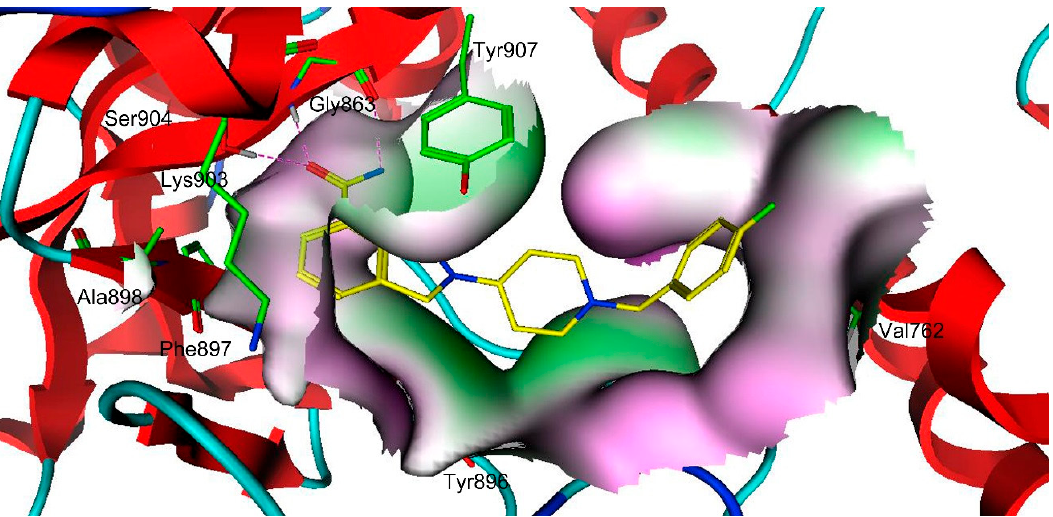
Figure 6. The three-dimensional (3D) ligand–protein interaction diagram for the binding site of PARP-1 with compound 1 . The active site residues are shown in green stick form. The hydrogen-bond network with protein residues is represented in red dotted lines. Compound 1 is color-coded by yellow.